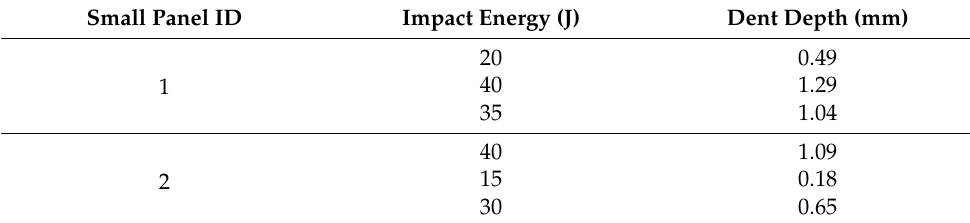
Table 2. Overview of impact damage in the Omega profile.